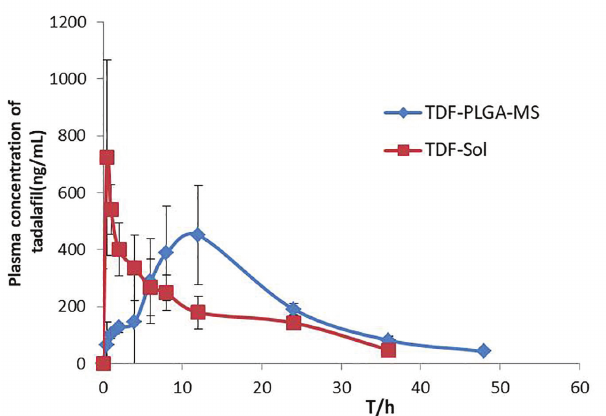
FIGURE 7 - Mean drug concentration–time curves of TDF in plasma after intratracheal instillation of TDF -Sol and TDF- PLGA-MS.